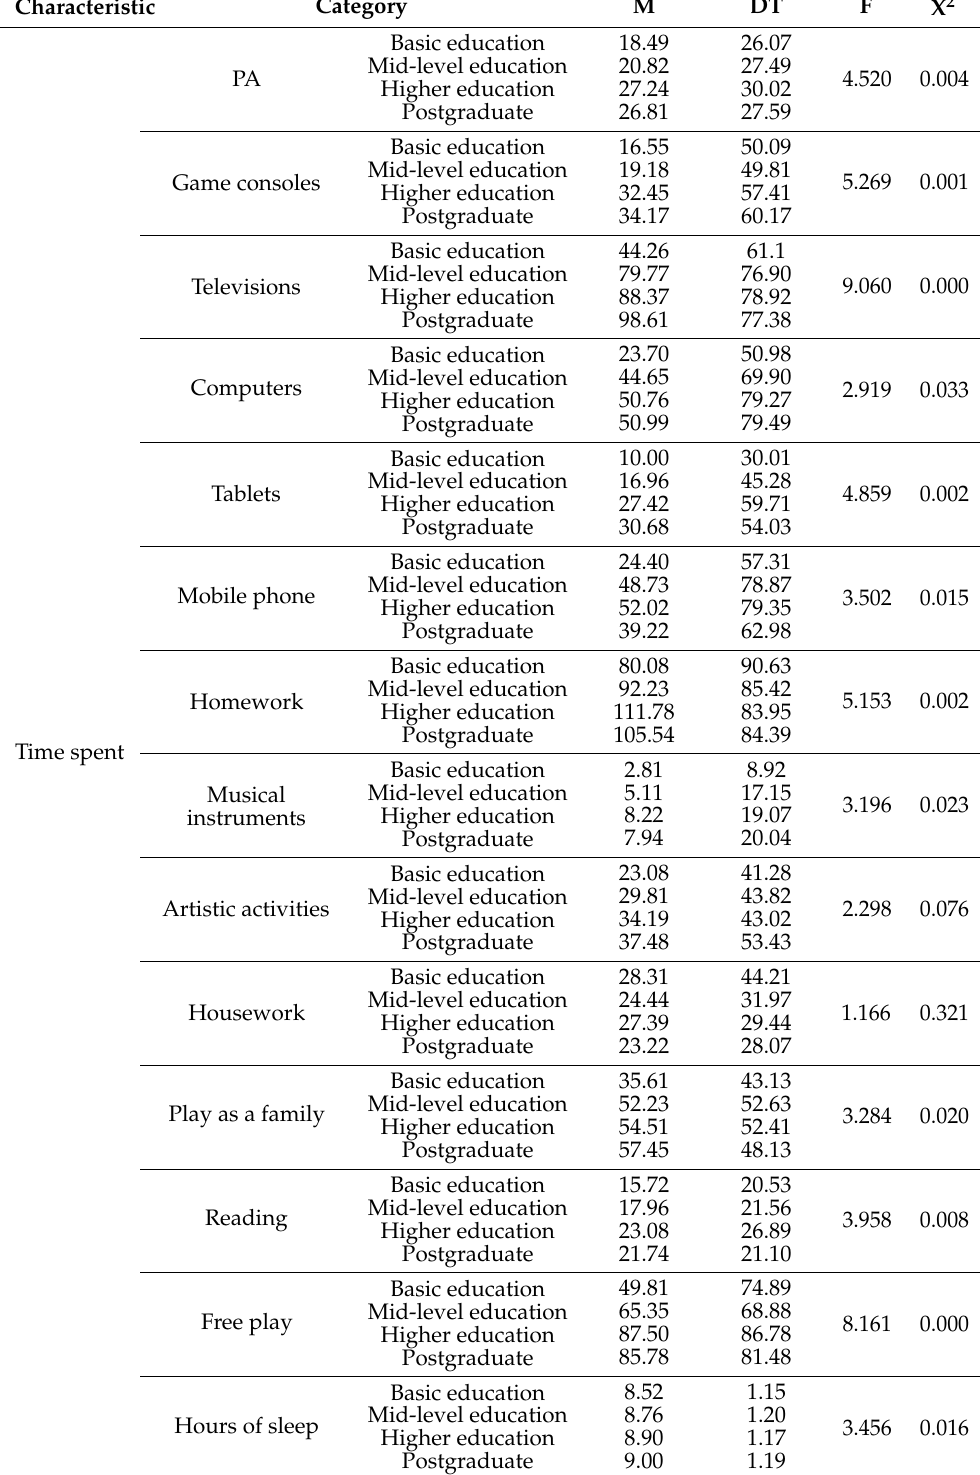
Table 8. Time of use of technological devices and daily actions (expressed in minutes) during confinement according to the educational level of Ibero-American